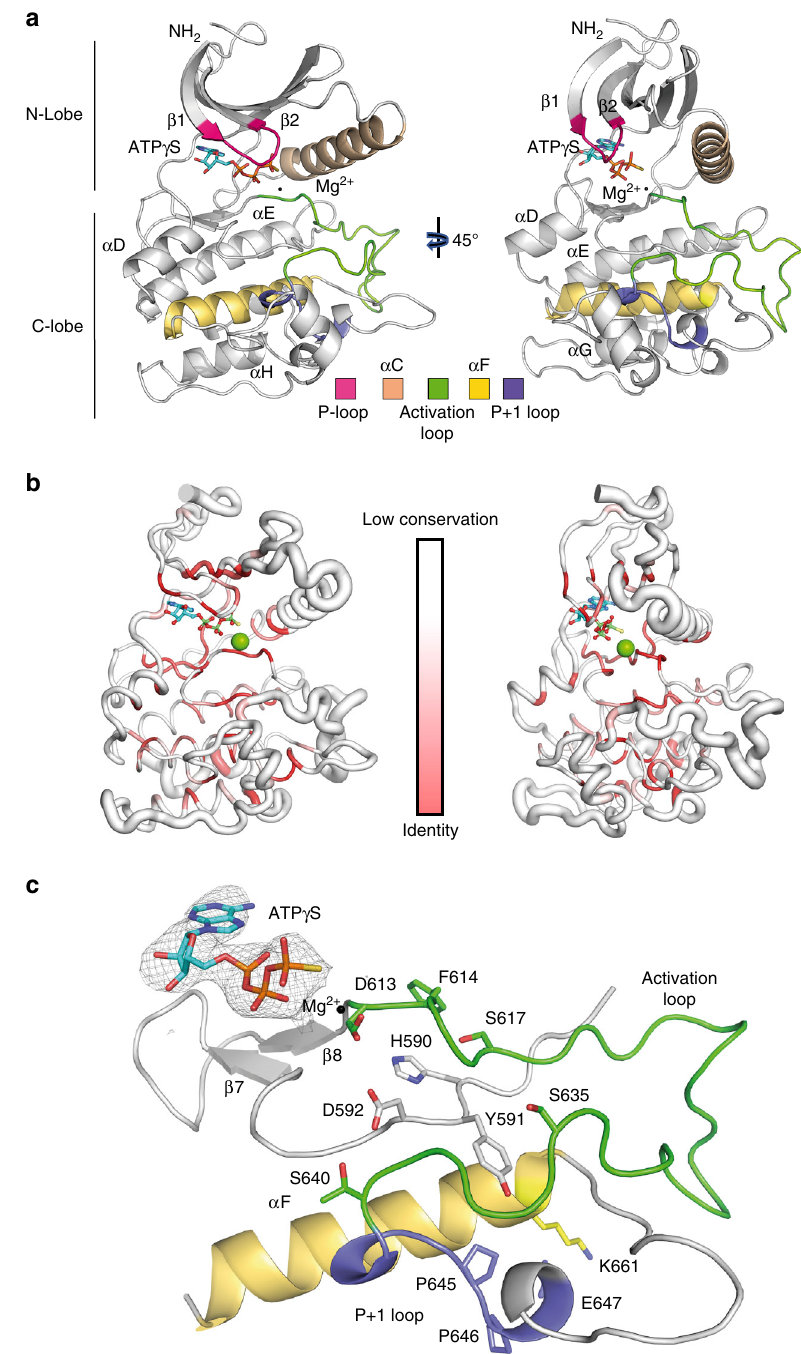
Fig. 4 Crystal structure of TLK2 kinase domain. a Ribbon diagram of the TLK2 kinase domain structure in complex with ATP γ S. The protein fold shows the classical N- and C-lobes and the important regulatory features associated with the kinase domain. The singular activation loop of TLK2 can be fully traced in the structure (see Table 1 for data collection and re fi nement). b To correlate structural and sequence conservation, we generated a sausage plot, showing a variable tube representation of the C α trace after a PDB query for performed with ENDSCRIPT. For this drawing, homologous protein structures (1291 PDB fi les) were superposed onto the TLK2 kinase domain structure with ProFit. The size of the tube is proportional to the mean r.m.s. deviation per residue between C α pairs. The white to red colour ramping is used to visualize sequence conservation . c A detailed view of the structure showing the ATP γ S, catalytic and activation loops, P + 1 loop and the α F helix. The key regulatory residues such as the DFG loop, the HYD, E647 and K661 are depicted in sticks. An omit map for the ATP γ S molecule at 1.25 σ level is included in the fi